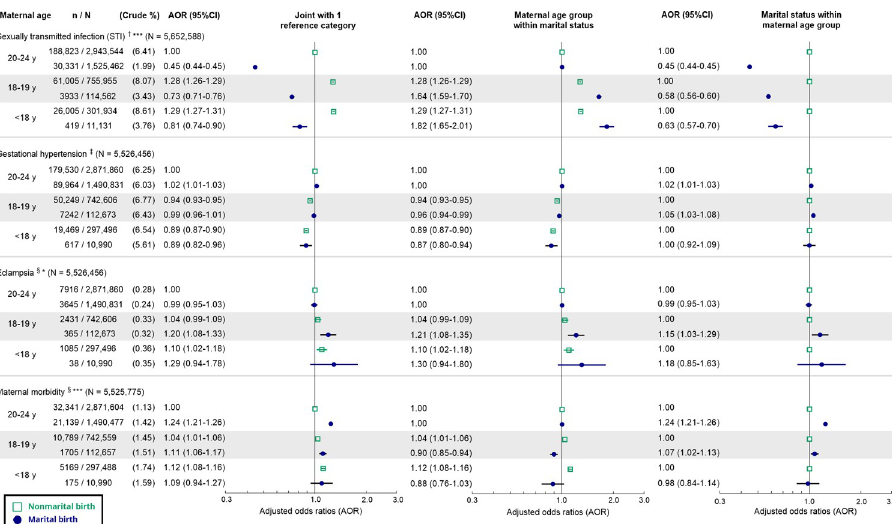
Fig 2. Adjusted odds ratios of maternal health indicators associated with the interaction between marital status and maternal age group. AOR plotted on the logarithmic scale. † Adjusted for maternal race/ethnicity, maternal US- born status, parity, paternal age, WIC benefits received, Medicaid as main payor of the delivery, and birth year. ‡ Adjusted for maternal race/ethnicity, maternal US-born status, parity, maternal smoking, prenatal care adequacy, any diabetes (preexisting or gestational), paternal age, WIC benefits received, Medicaid as main payor of the delivery, and birth year. § Adjusted for maternal race/ethnicity, maternal US-born status, parity, maternal smoking, prenatal care adequacy, any diabetes (preexisting or gestational), preexisting hypertension, paternal age, WIC benefits received, Medicaid as main payor of the delivery, and birth year. � p < 0.05, ��� p < 0.001 for interaction term between marital status and maternal age group. AOR, adjusted odds ratio; WIC, Special Supplemental Nutrition Program for Women, Infants, and Children.